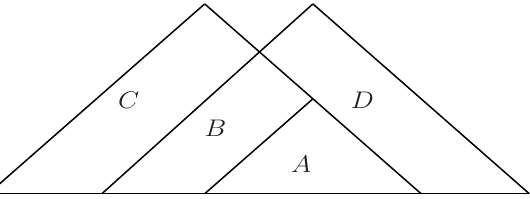
Figure 3. The relationships among the quasi-cancellative CA-groupoid, separative CA-groupoid and commutative